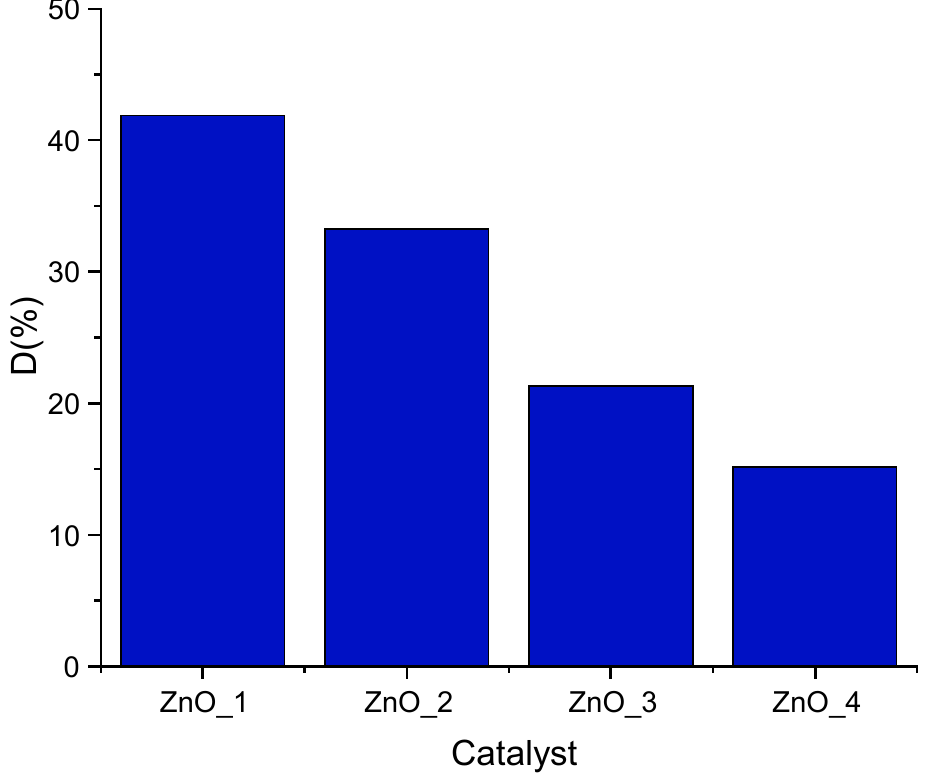
Figure 9. Degradation efficiencies of ZnO samples for MB photodegradation after 40 min (1.5 mg ZnO and 5 ppm MB).